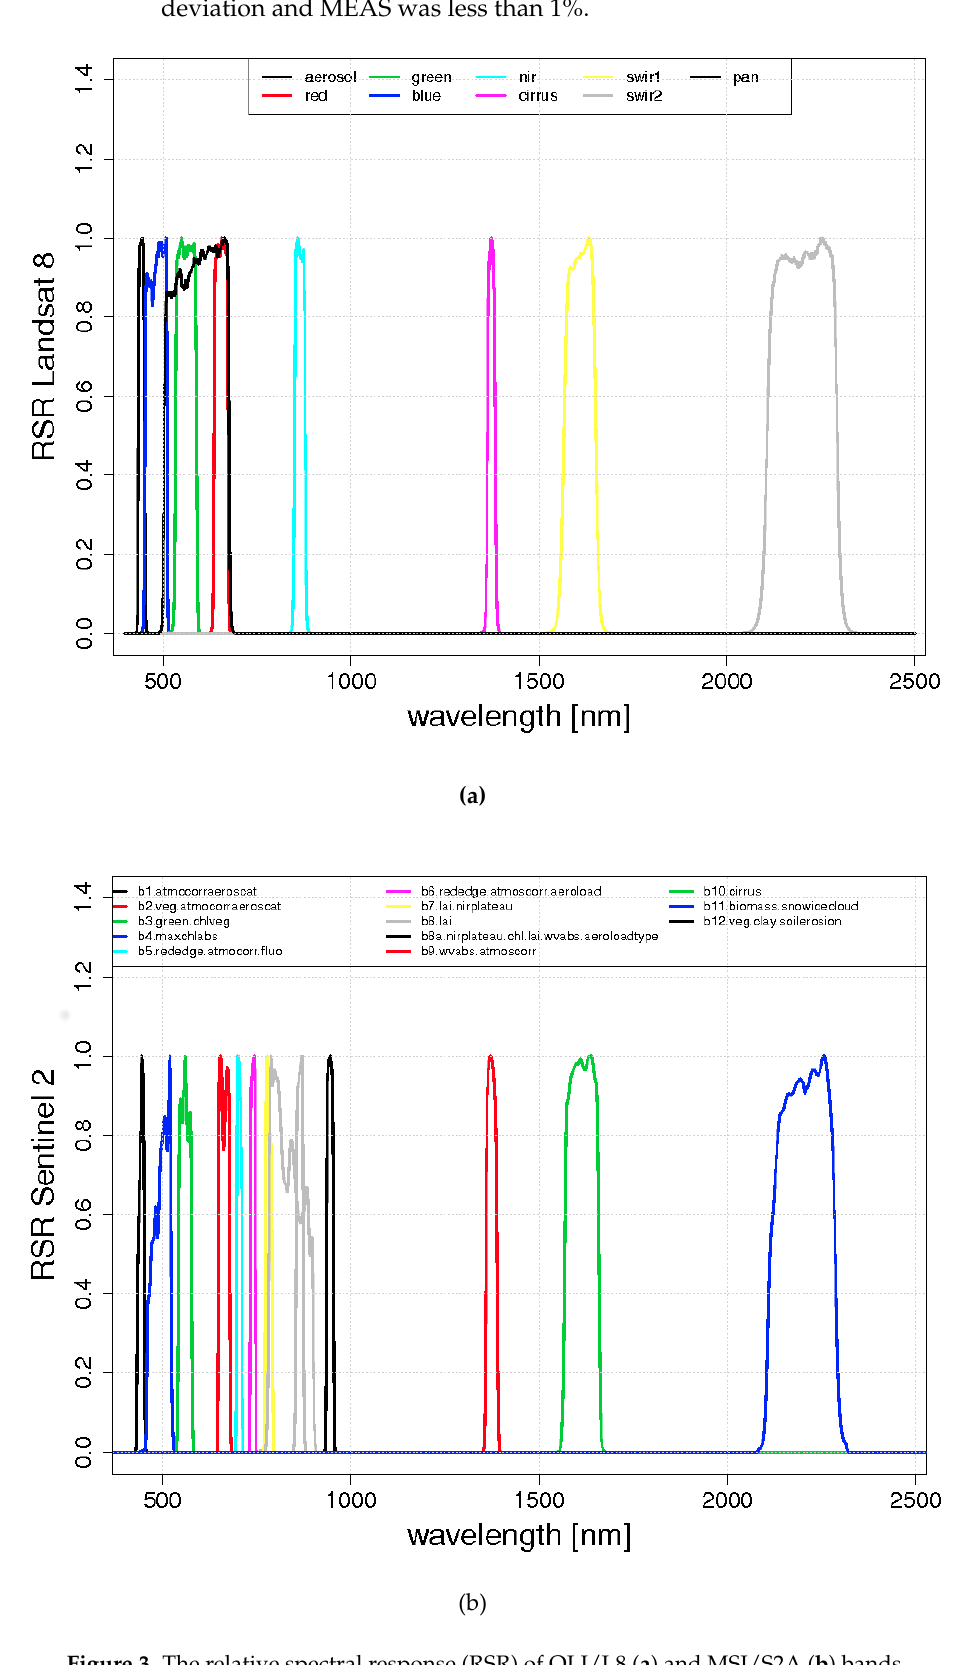
Figure 3. The relative spectral response (RSR) of OLI/L8 ( a ) and MSI/S2A ( b ) bands.